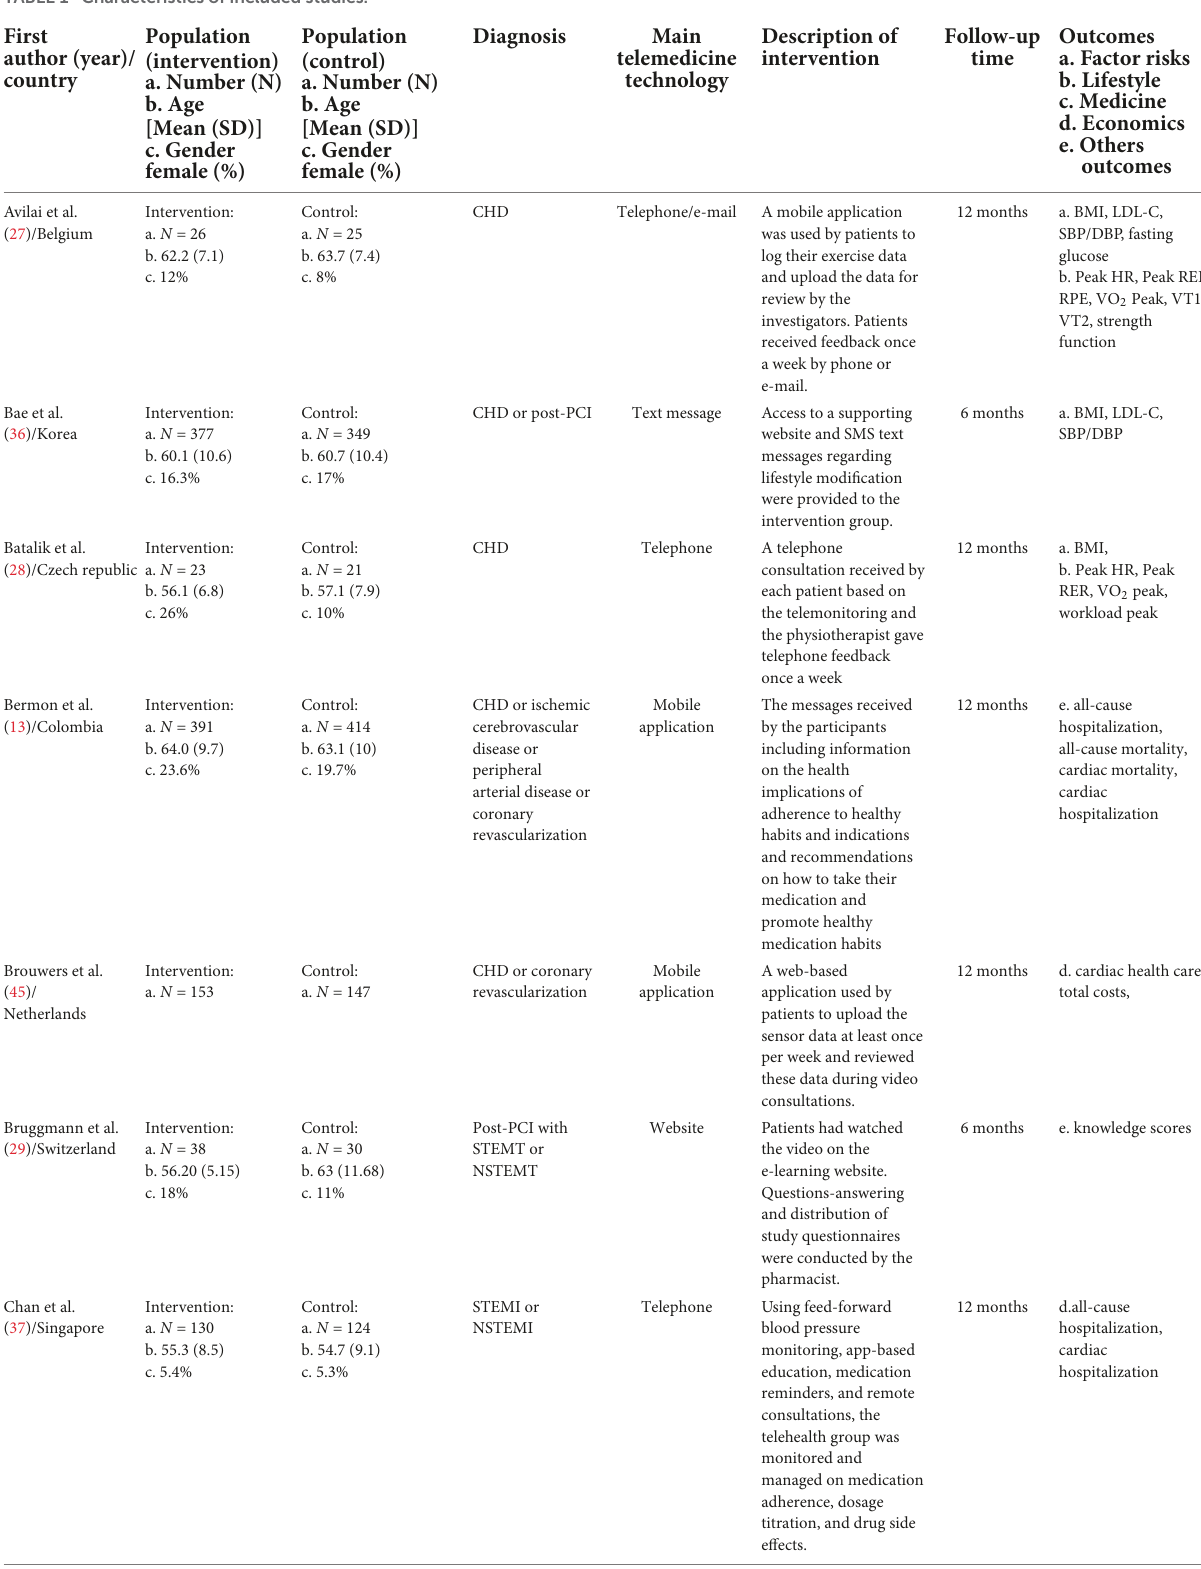
TABLE 1 Characteristics of included